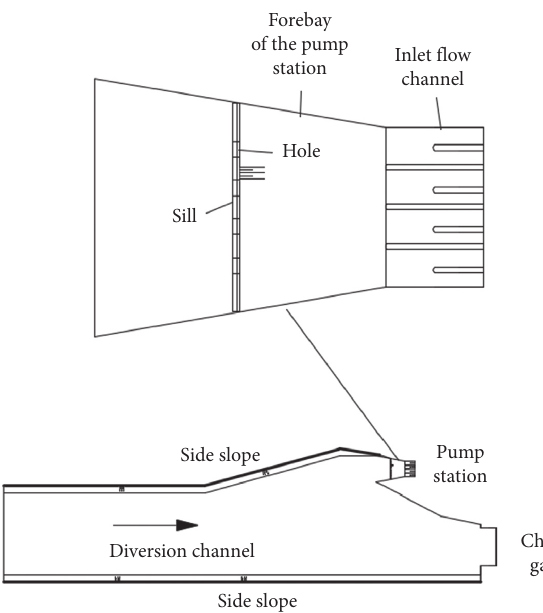
Figure 2: Schematic diagram of the water intake model of the pump